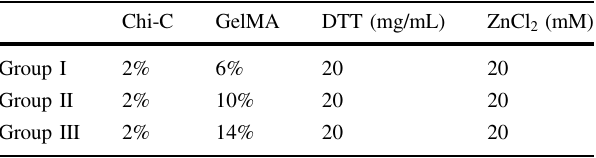
Table 1 The concentration (m/m) of different component in the hydrogel